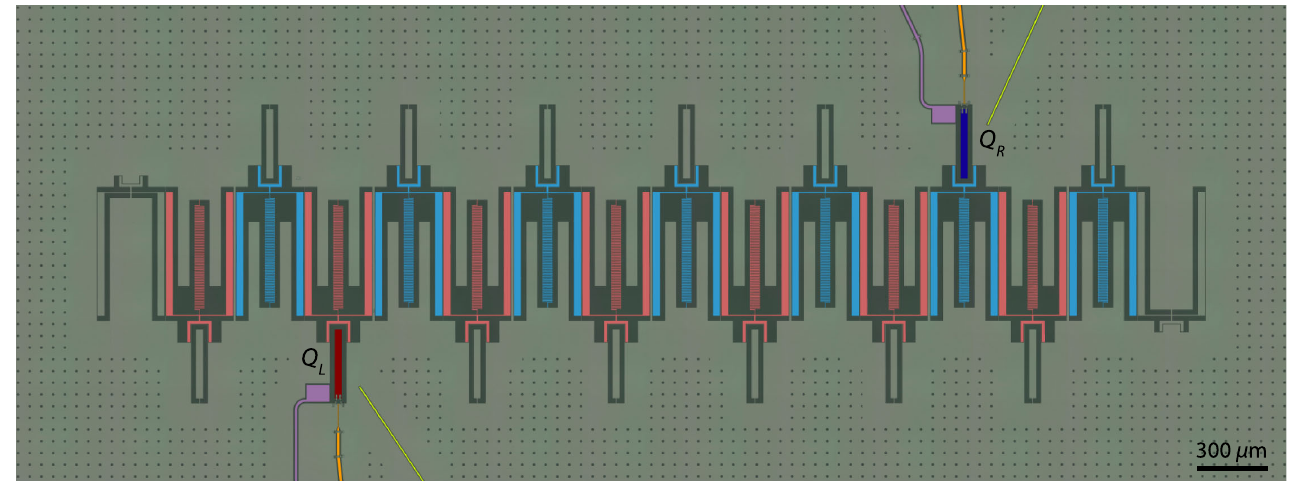
FIG. 16. The device consists of a topological waveguide with 7 unit cells [resonators corresponding to A ( B ) sublattice colored red (blue)] in the topological phase, where the intercell coupling is larger than the intracell coupling. Two qubits Q blue) are coupled to A sublattice of the second unit cell and B sublattice of the sixth unit cell, respectively. Each qubit is coupled to a λ = 4 coplanar waveguide resonator (purple) for dispersive readout, flux-bias line (orange) for frequency control, and charge line (yellow) for local excitation